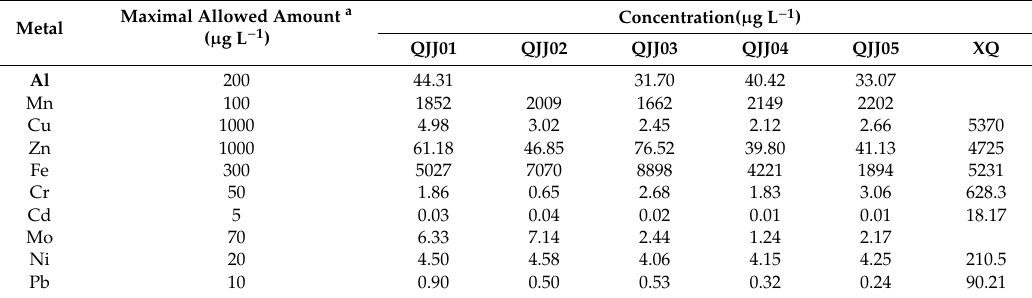
Table 1. Metal detection results of water samples in the study area.